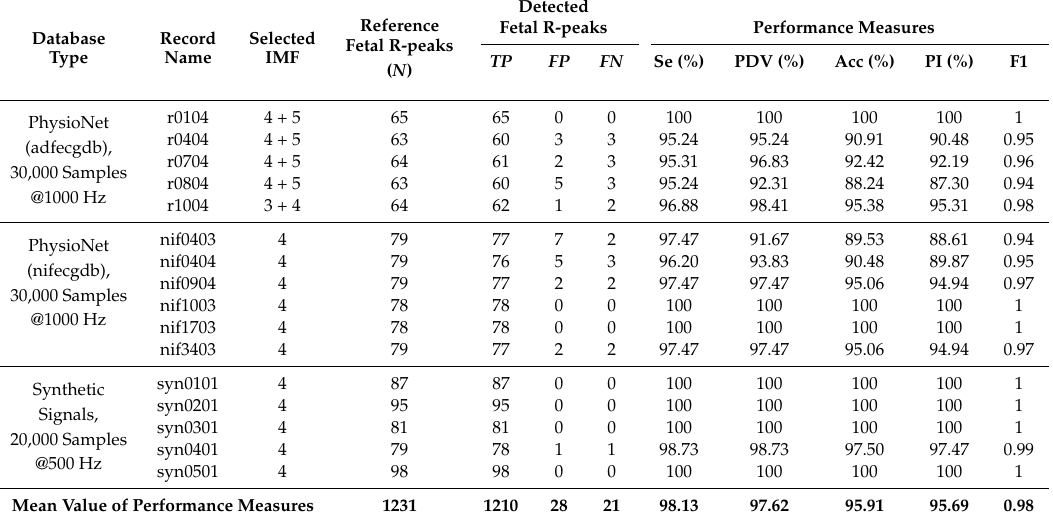
Table 5. Results of the fetal R-peak detection and its various performance